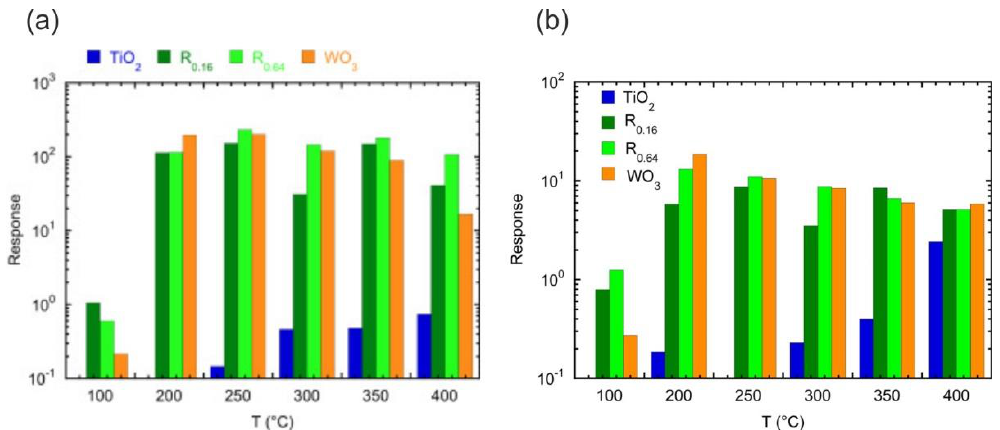
Figure 8. ( a ) Response of the indicated sensors to 100 ppm of acetone as a function of the operating temperature (Reproduced with permission [80]). ( b ) Response to 100 ppm of ethanol as a function of the operating temperature for the indicated sensors (Reproduced with permission [81]).